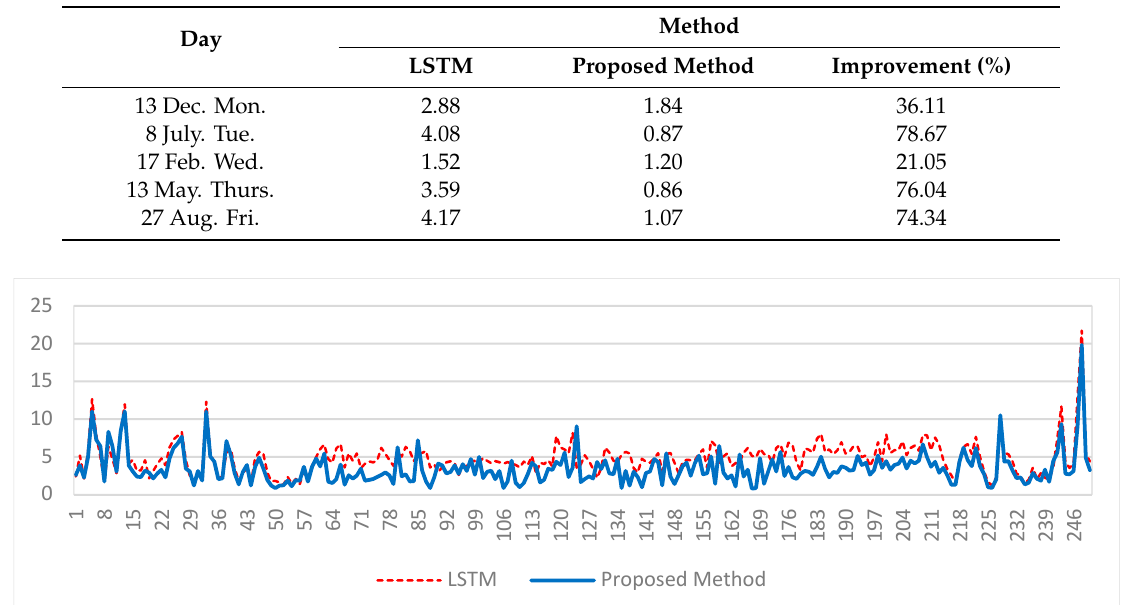
Table 2. MAPE of LSTM and proposed method for five randomly chosen days in the testing data.